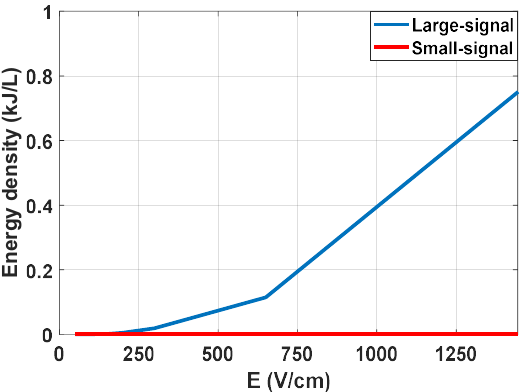
Figure 6. Average energy density applied as a function of the electric field.